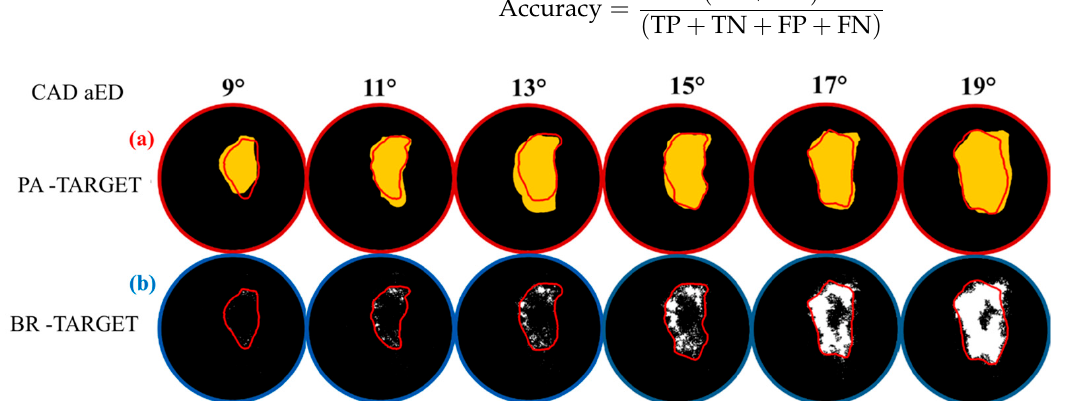
Figure 13. Comparison between ( a ) PA and ( b ) BR methods in determining the flame front in the first instants after the end of the discharge at λ = 1.6. The red lines on the images indicate the contour of the Target flame front whereas the yellow and white areas the flame front computed by PA and BR, respectively.